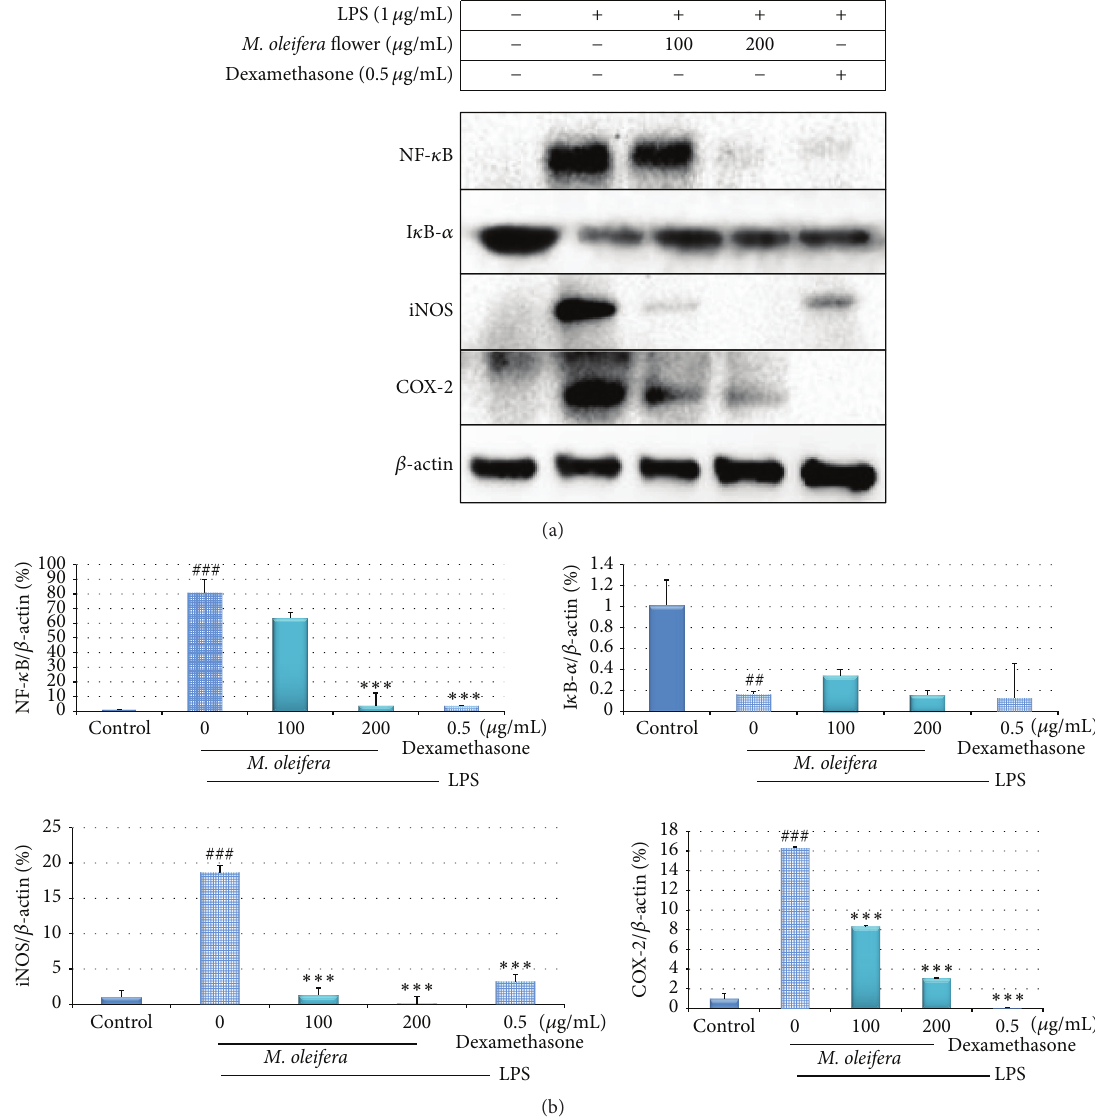
Figure 6: (a) Anti-inflammatory effect of 80% hydroethanolic M. oleifera bioactive flower extract on the expression of NF- 𝜅 B, I 𝜅 B- 𝛼 , iNOS, and COX-2 in LPS-induced RAW 264.7 macrophages. A density of 1 × 10 6 cells/well of macrophages in the presence or absence of LPS were seeded in 6-well plate and treated with indicated concentrations of flower extract for 24 h. The protein of cells was collected through RIPA buffer and analysed by Western blotting. 𝛽 -actin acts as a loading control and also standard for target proteins in quantitative determination. (b) Densitometry analysis results of the effect of M. oleifera flower extract on proteins expression. ### 𝑝 < 0.001 and ## 𝑝 < 0.01 were LPS- treated group versus control; ∗∗∗ 𝑝 < 0.001 : treated group significantly different from LPS-treated group. Control: basal level of cytokines released without LPS induction. The data are presented as mean ± SD of three independent experiments.